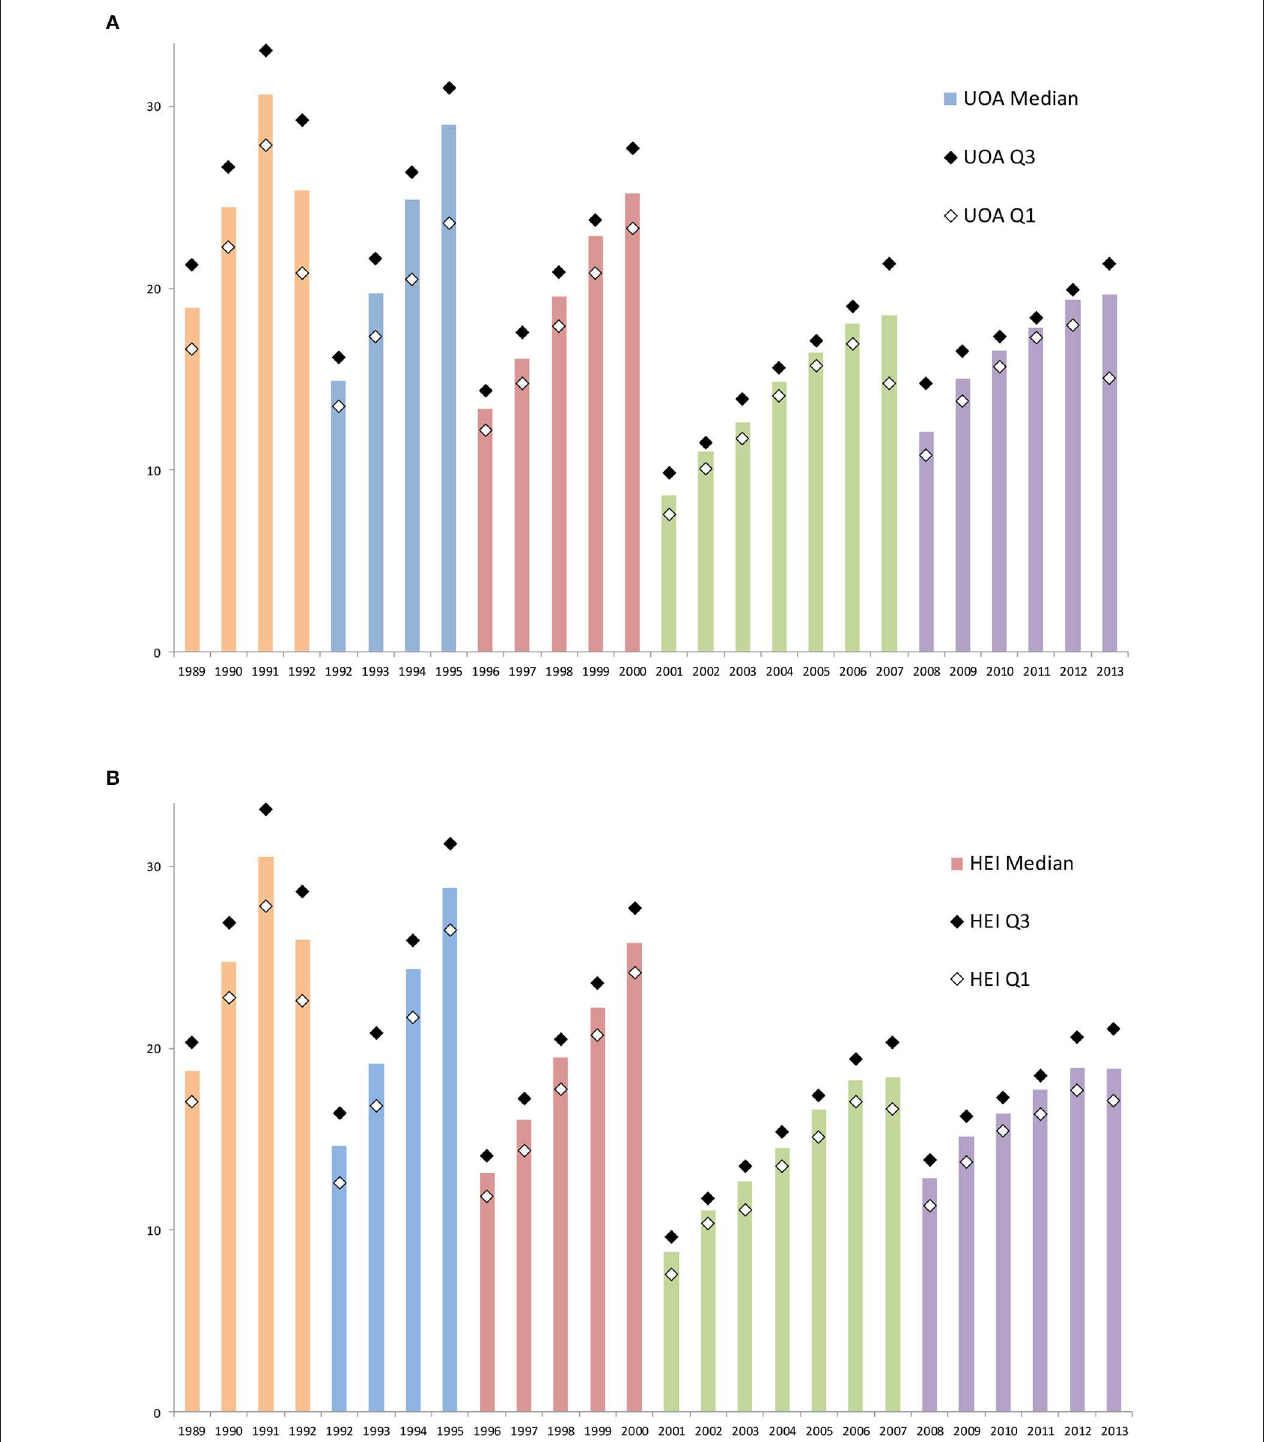
FIGURE 4 | The share of outputs submitted to each year of a census period in successive cycles of the UK Research Assessment Exercise (1992–2008) and Research Excellence Framework (2014). Data are aggregated by year of publication and shown as a percentage of the total submissions for that cycle. (A) The median and the lower (Q1) quartile and upper (Q3) shares for data aggregated at the level of subject-based Units of Assessment (UOA). (B) The median and the lower (Q1) quartile and upper (Q3) shares for data aggregated at the level of submitting Higher Education Institutions (universities and colleges, HEIs).